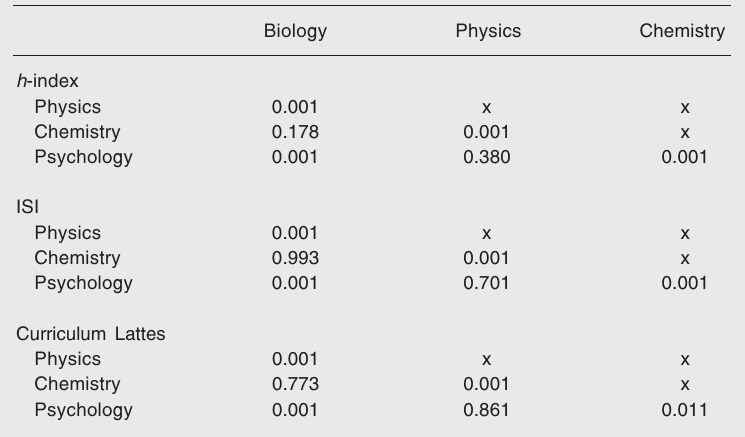
Table 2 . P values of the hypothesis test concerning equality between Departments